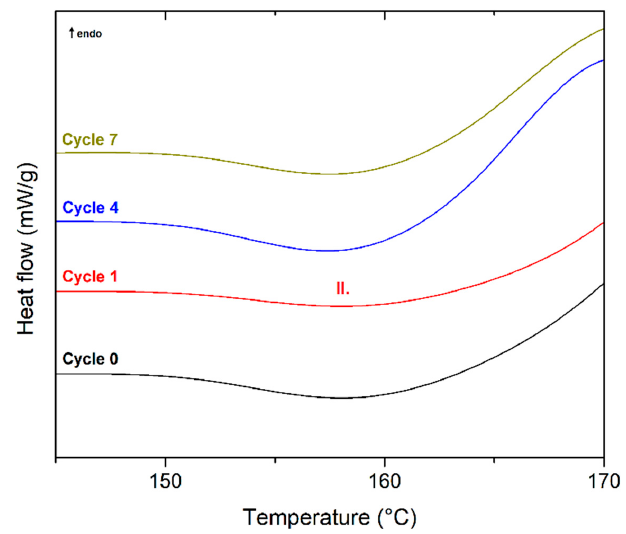
Figure 5. DSC curves (first heating) of PLLA as a function of recycling cycle. Table 3. Thermogravimetric analysis of PLLA and PHBV as a function on the number of recycling cycles. Polymer Degradation